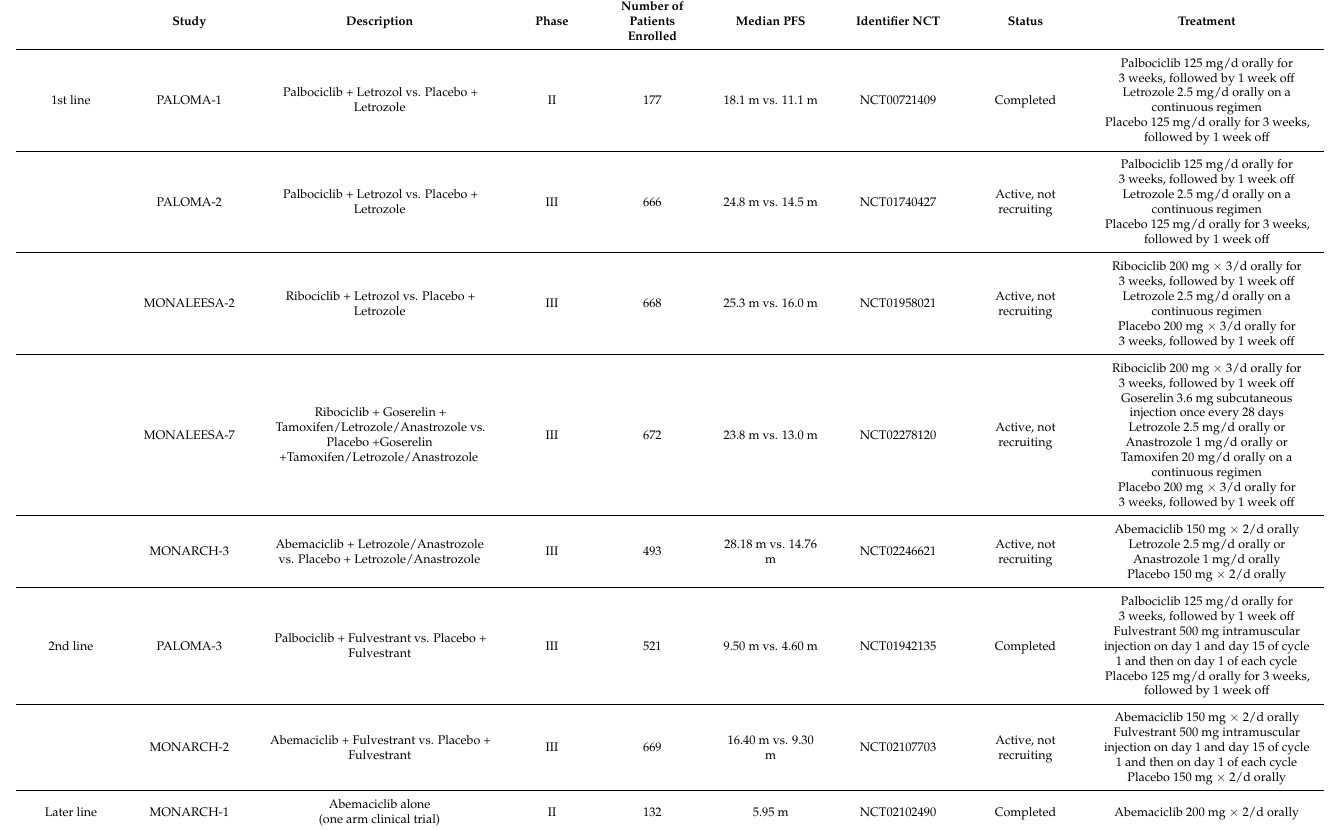
Table 1. Pivotal studies on the three approved CDK4/6